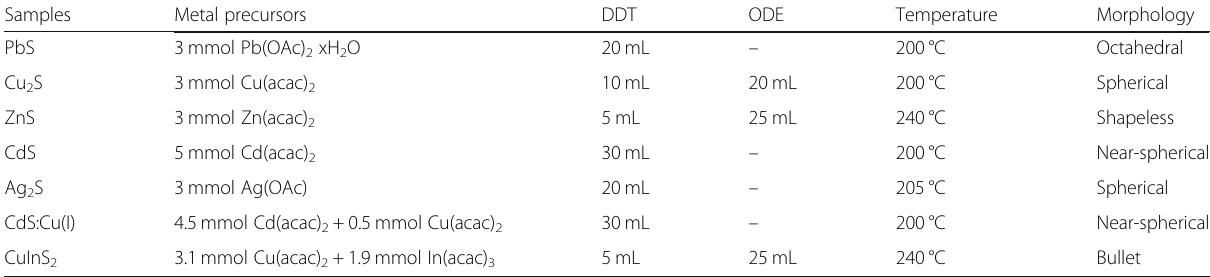
Table 1 Detailed experimental conditions for synthesis of different types of metal sulfide NCs Samples